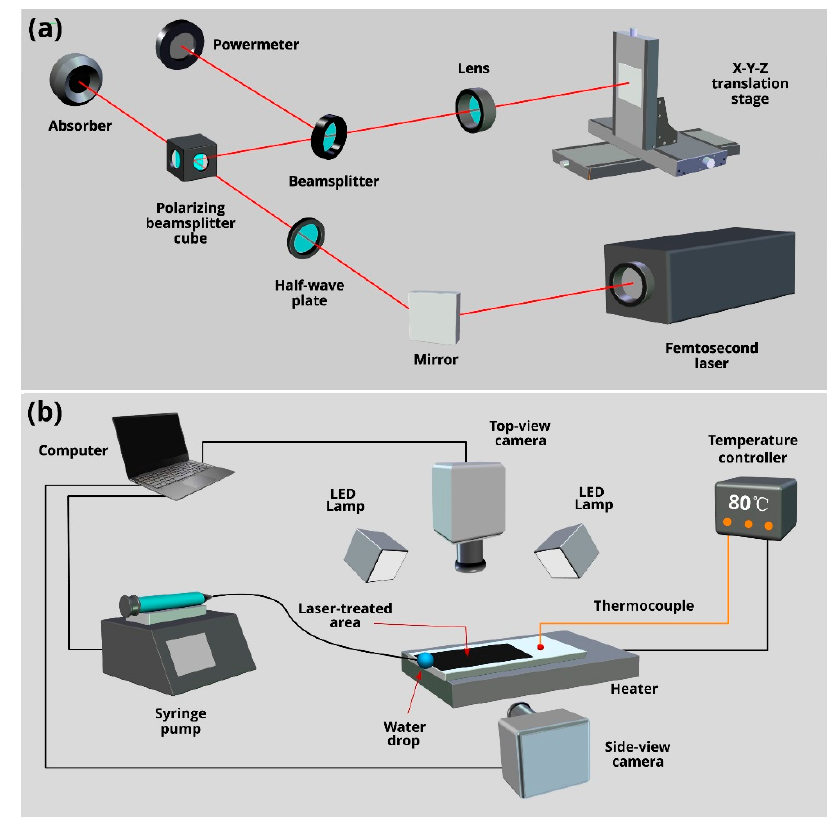
Figure 1. ( a ) Femtosecond laser setup for producing an array LIPSS-structured micropillars/microholes. ( b ) Experimental setup for high-speed video capturing of water spreading on the wicking surface at various temperatures.